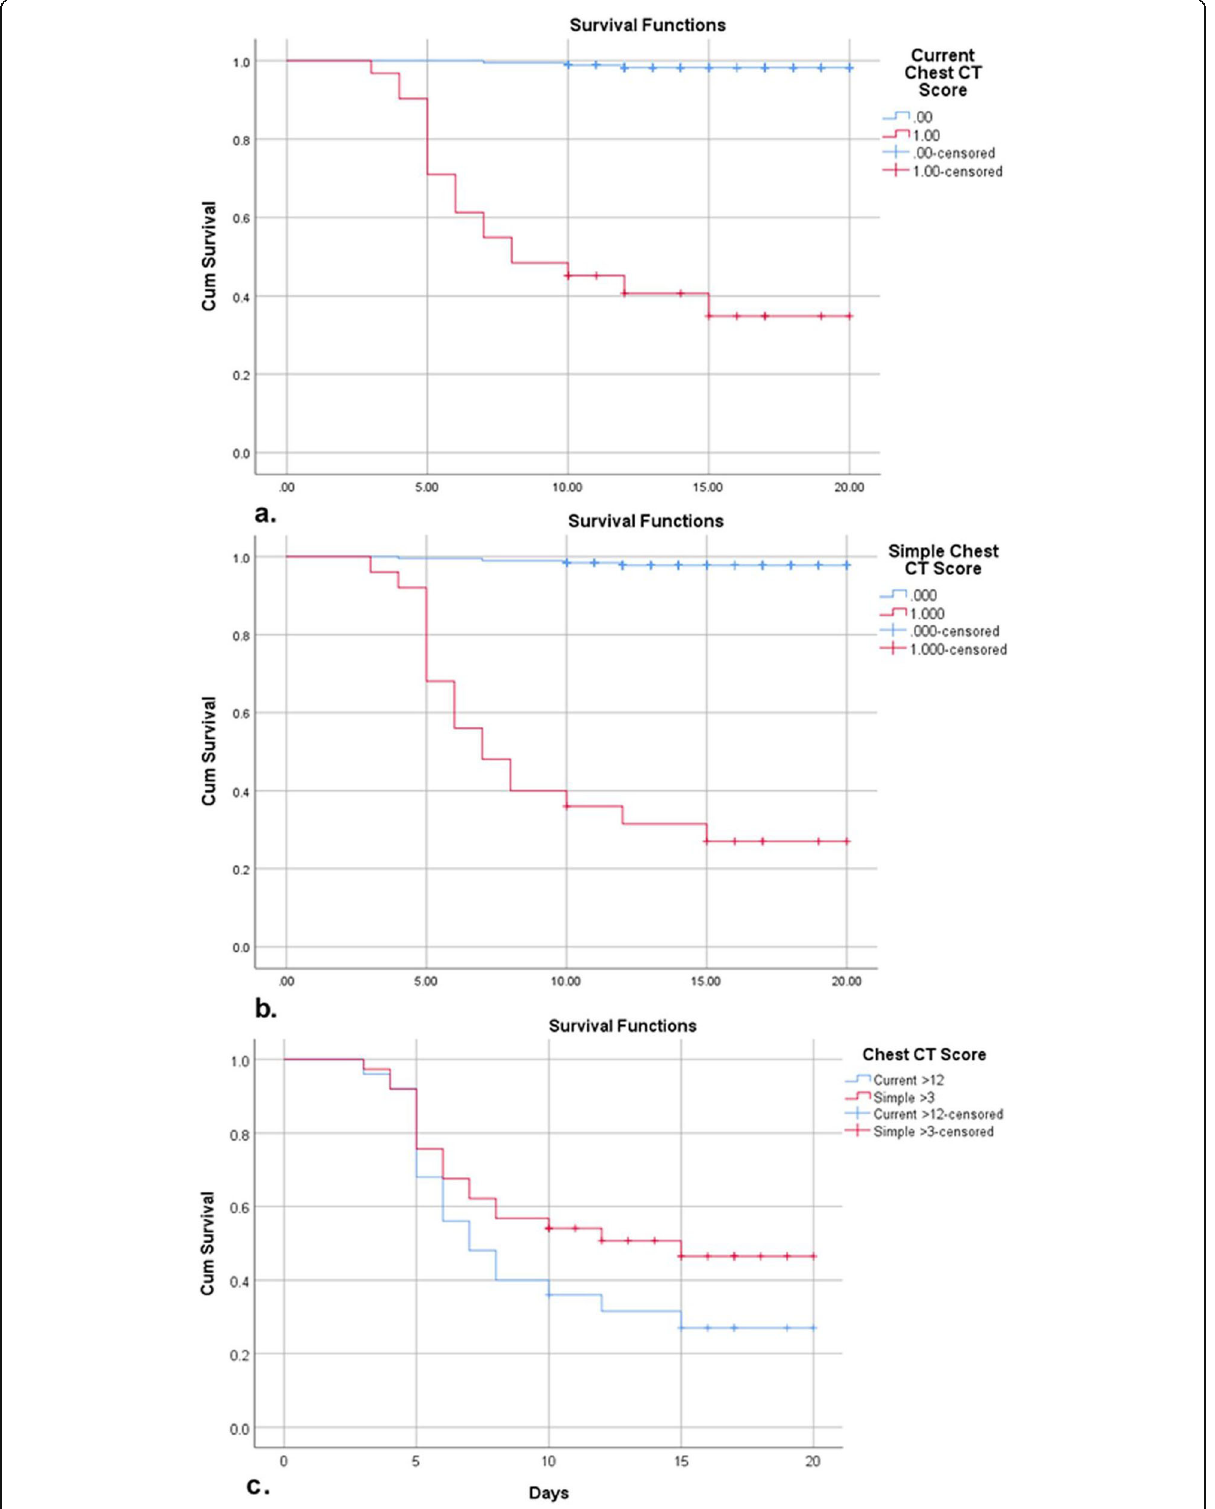
Fig. 8 The Kaplan – Meier survival curves show the comparison of survival rates. a Comparison of estimated survival rate between patients with a score of ≤ 12 and patients with a score of > 12 using current chest CT score. b Comparison of estimated survival rate between patients with a score of ≤ 3 and patients with a score of > 3 using simple chest CT score. c Comparison between two scores regarding estimated survival